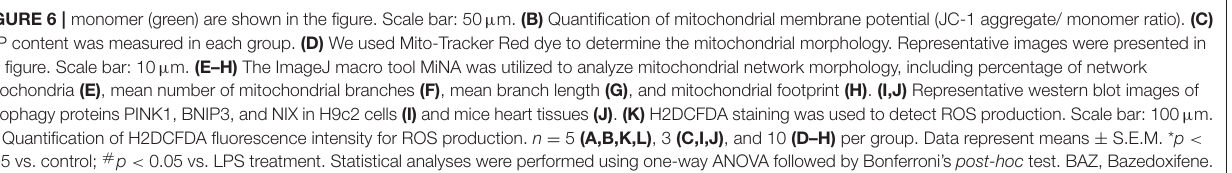
FIGURE 6 | monomer (green) are shown in the figure. Scale bar: 50 µ m. (B) Quantification of mitochondrial membrane potential (JC-1 aggregate/ monomer ratio). (C) ATP content was measured in each group. (D) We used Mito-Tracker Red dye to determine the mitochondrial morphology. Representative images were presented in the figure. Scale bar: 10 µ m. (E–H) The ImageJ macro tool MiNA was utilized to analyze mitochondrial network morphology, including percentage of network mitochondria (E) , mean number of mitochondrial branches (F) , mean branch length (G) , and mitochondrial footprint (H) . (I,J) Representative western blot images of mitophagy proteins PINK1, BNIP3, and NIX in H9c2 cells (I) and mice heart tissues (J) . (K) H2DCFDA staining was used to detect ROS production. Scale bar: 100 µ m. (L) Quantification of H2DCFDA fluorescence intensity for ROS production. n = 5 (A,B,K,L) , 3 (C,I,J) , and 10 (D–H) per group. Data represent means ± S.E.M. * p < 0.05 vs. control; # p < 0.05 vs. LPS treatment. Statistical analyses were performed using one-way ANOVA followed by Bonferroni’s post-hoc test. BAZ,